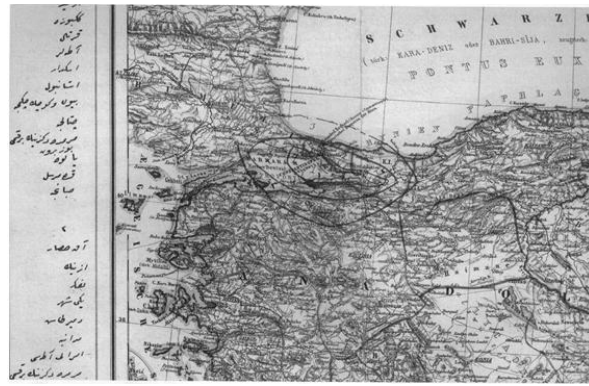
Figure 6. Isoseist map of the 1894 earthquake, prepared by D. Egenistis.